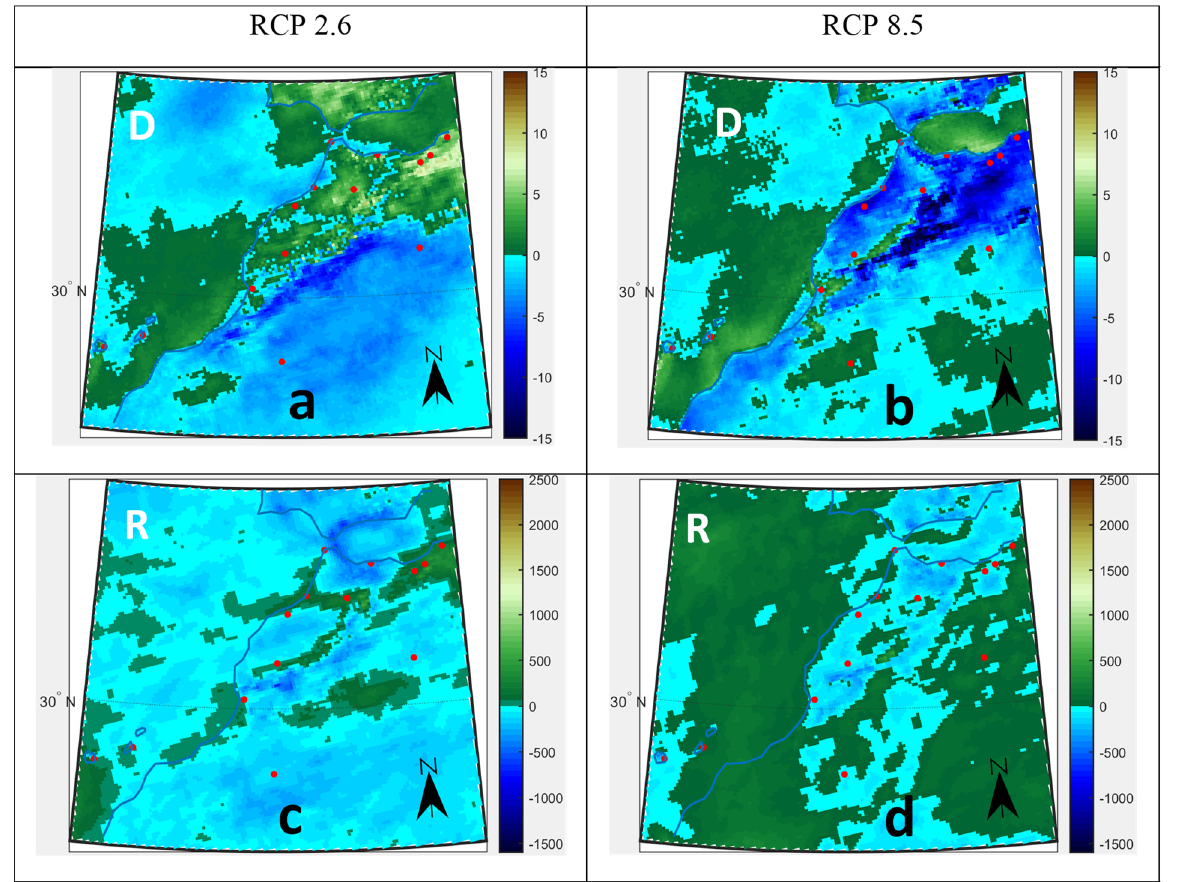
Figure 8. Spatial variation of the difference in yearly dew and rain yields ∆ H d / r , y between 2100 and 2006 according to ( a , c ) scenario RCP 2.6 and ( b , d ) scenario RCP 8.5. Dew: ( a , b ); Rain: ( c , d ). Red points: airport stations described in Table 1 and Figure 1.